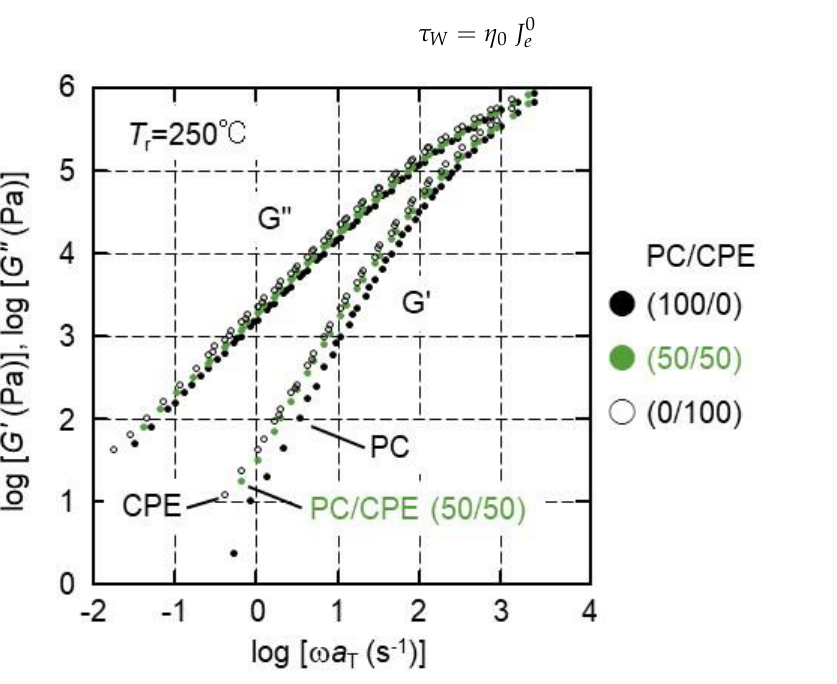
Figure 7. Master curves of angular frequency dependence of shear storage moduli G ′ and loss moduli G ″ for PC, CPE, and PC/CPE (50/50). The reference temperature was 250 °C.